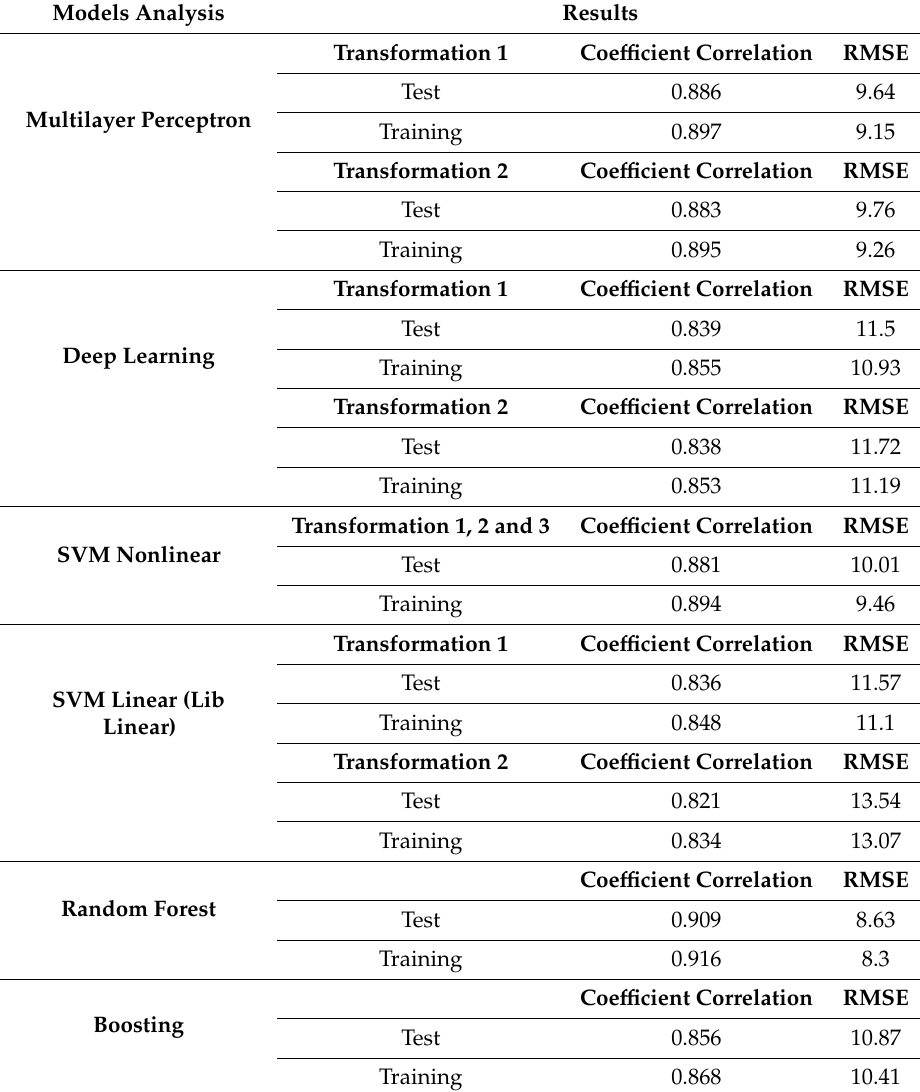
Table 5. Results of the di ff erent